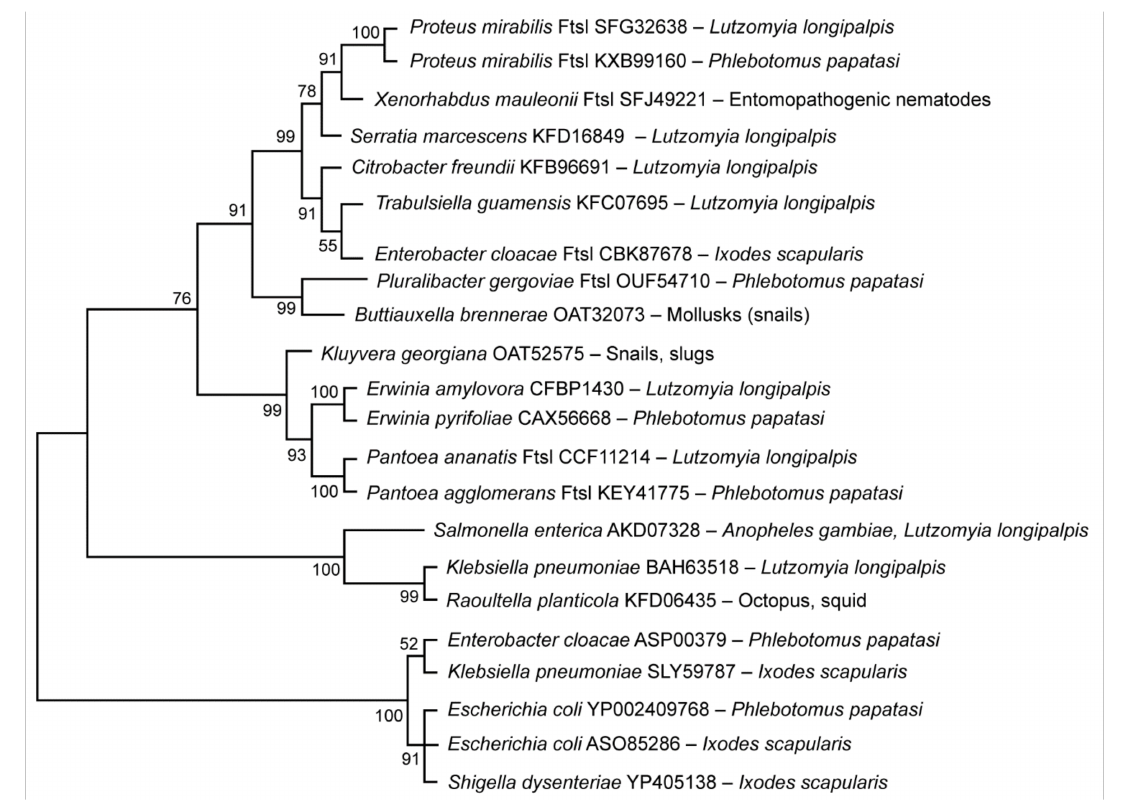
Figure 3. Comparison of the bacterial protein peptidoglycan synthetase in 22 members of the family Enterobacteriaceae (amino acid alignment in Supplementary Figure S2). Phylogenetic tree constructed using the maximum likelihood method. Genbank accession numbers and respective vectors/hosts follow the scientific names of the